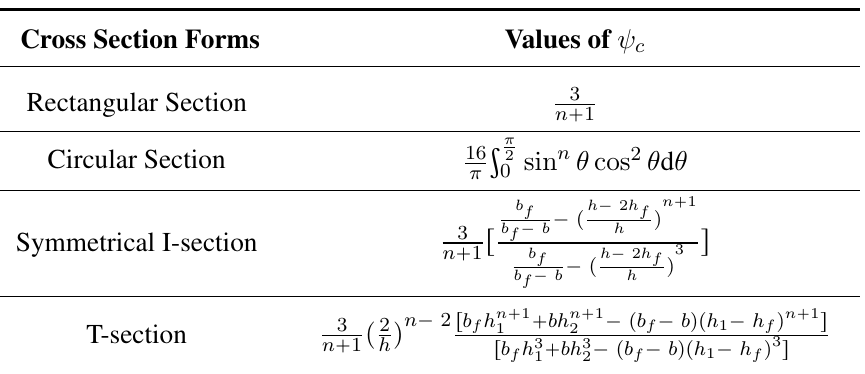
for some special cross c